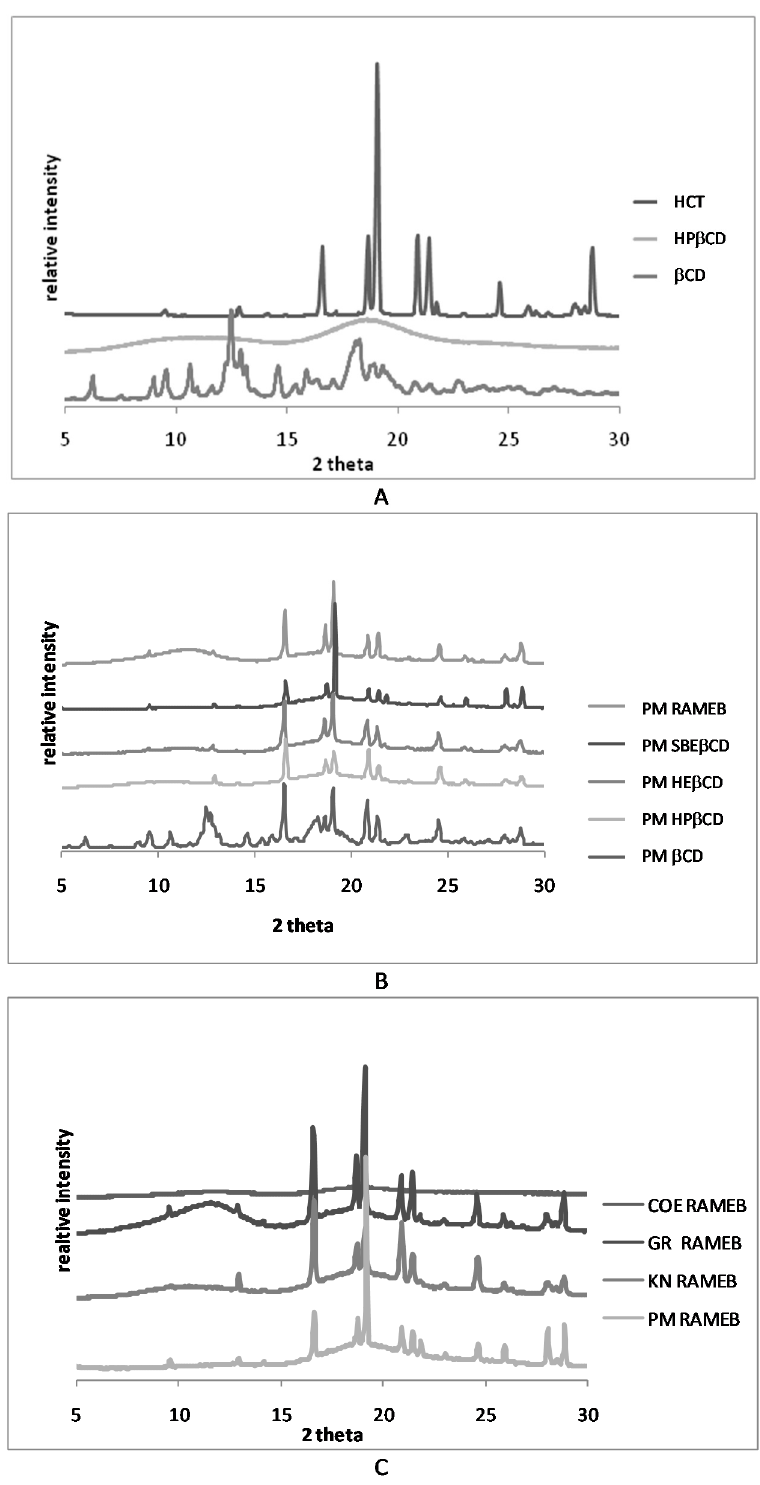
Figure 3. XRPD patterns of pure HCT and CDs ( A ) and of equimolar physical mixtures (PM) ( B ) with all CDs and the co-ground (GR), kneaded (KN), and co-evaporated (COE) products with RAMEB ( C ).